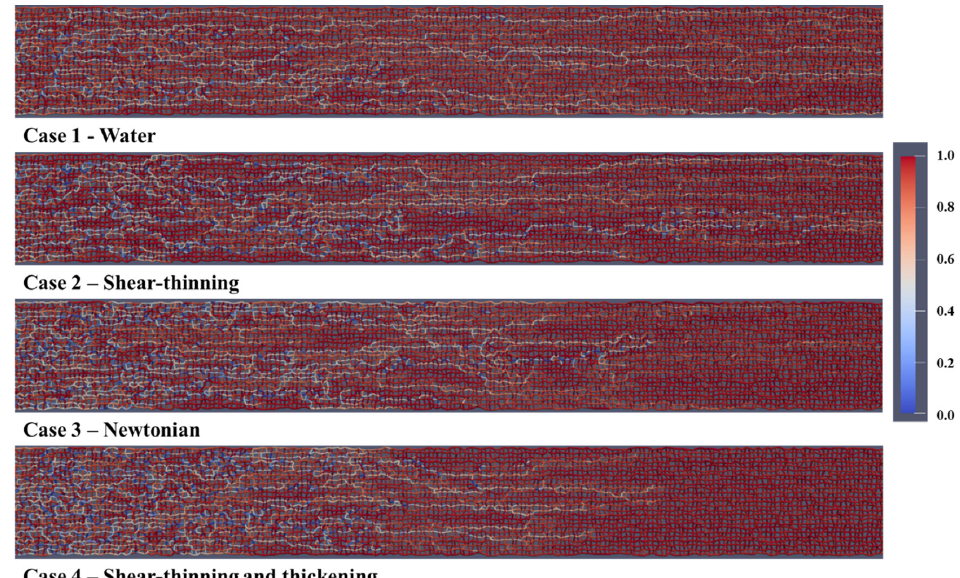
Figure 22. Fluid distribution (oil and water) after 0.1 PV of injected fluid with Q = 1 × 10 –13 m 3 /s for the longer (200 × 25) pore network model.